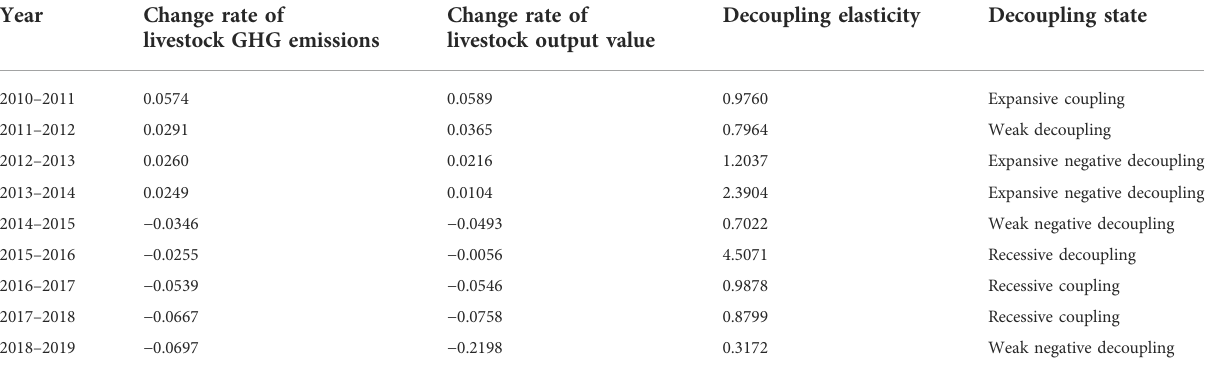
TABLE 4 Decoupling the relationship between livestock GHG emissions and output value in the